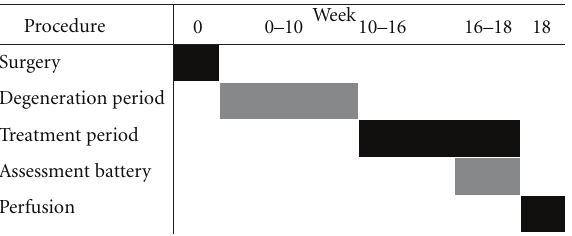
Figure 7: The experimental time course. Bilateral adrenalectomy (ADX) is conducted at the onset of the experiment. The granule cell layer of the dentate gryus degenerates significantly over the following ten weeks, during which rats remain in their homecages. A subset of ADX rats are exposed to a number of di ff erent treatment strategies, after which behavioural and electrophysiolog- ical measures can be taken. Upon completion of the experiment, rats are perfused and the granule cell layer is assessed using immunohistochemistry and unbiased stereological